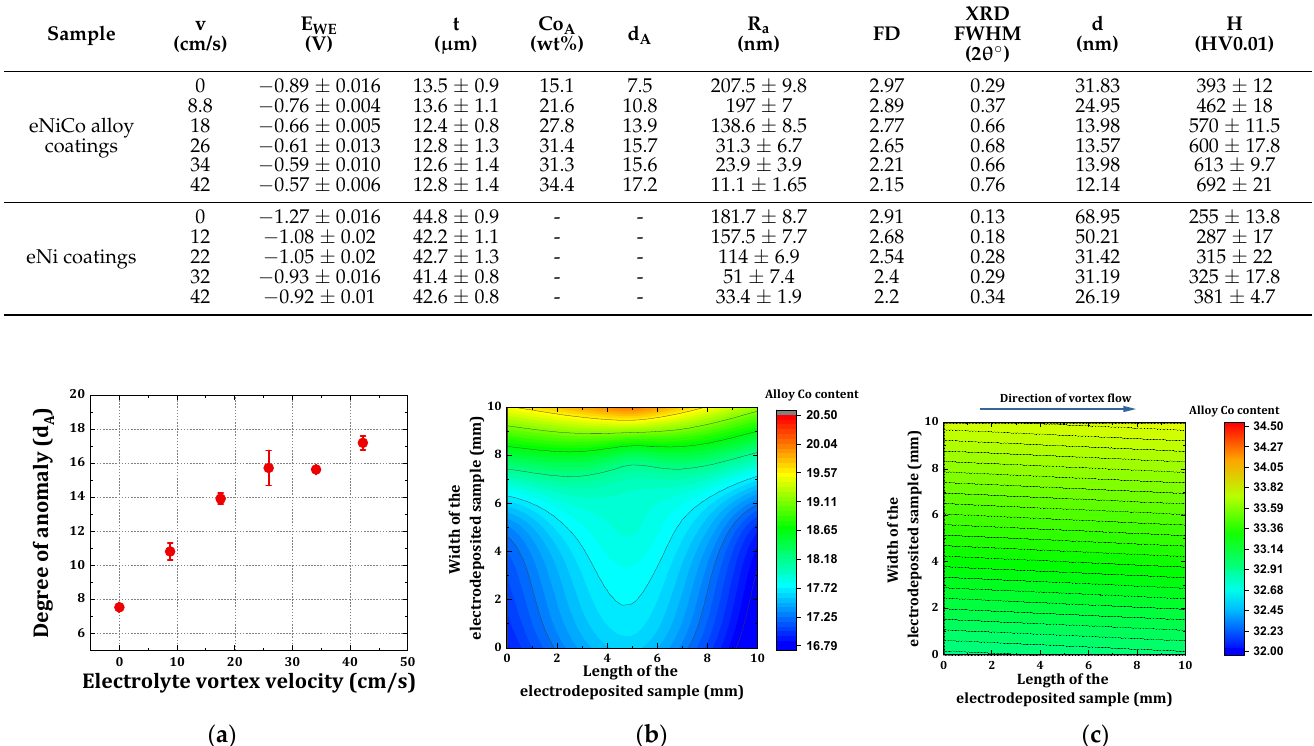
Table 2. Summary of electrochemical and micromechanical characterization of the eNiCo and eNi coating samples as function of BHD with varying v at j = 50 mA/cm 2 .